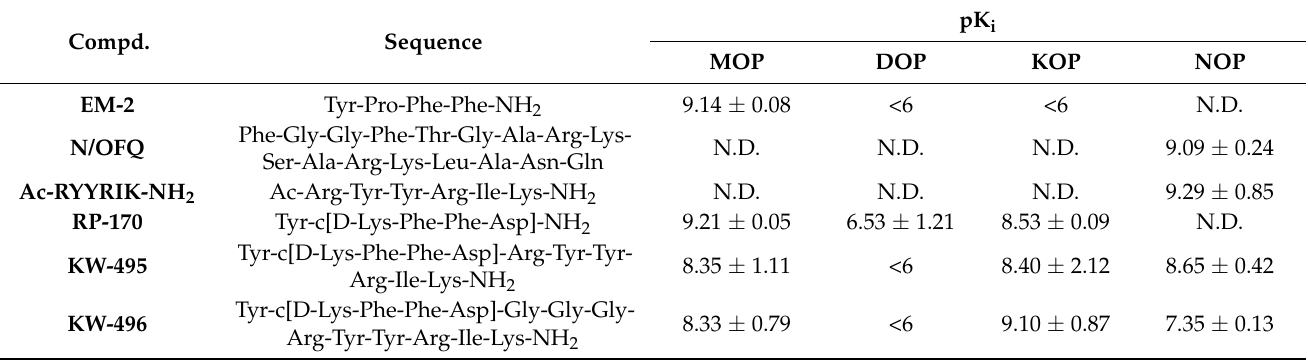
Table 1. Binding affinities of reference compounds and hybrid peptides at classical opioid and nociceptin